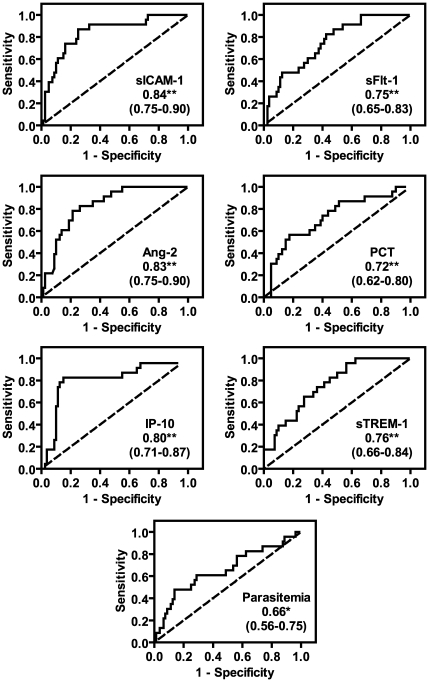
Assessment of biomarker utility in predicting outcome in children with severe malaria.A receiver operating characteristic (ROC) curve was generated for each biomarker. The dashed reference line represents the ROC curve for a test with no discriminatory ability. Area under the ROC curve is displayed on each graph with 95% confidence intervals in parentheses. p values were adjusted for multiple comparisons using Holm's correction (n = 7). * p<0.05 and ** p<0.01.